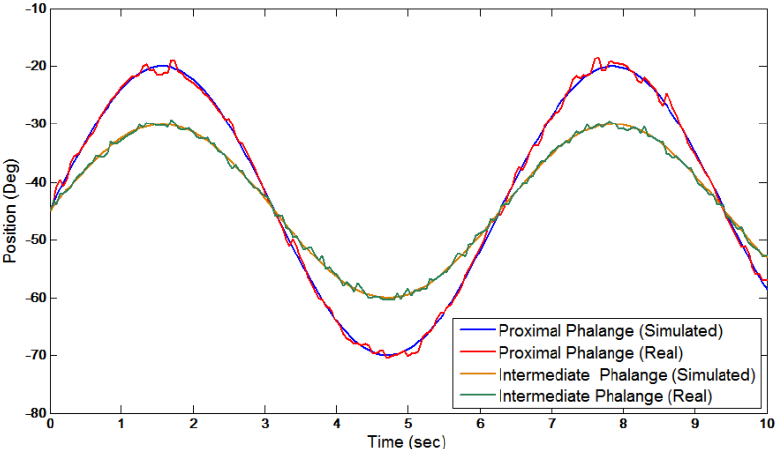
Figure 11. Simulated and actual trajectories of ExoK’ab device conducting a passive exercise.